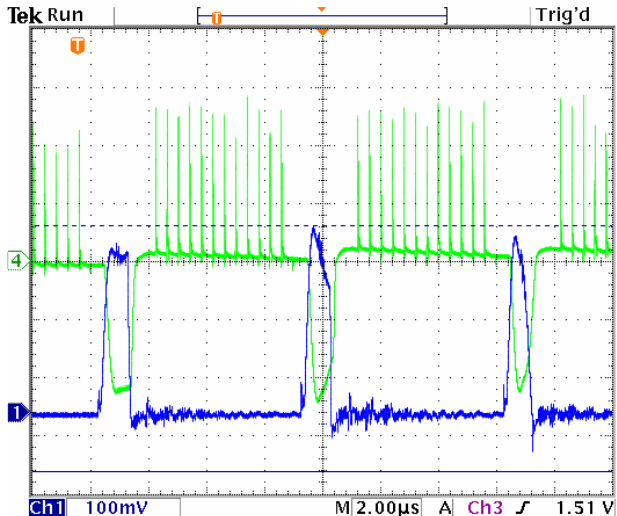
FIG. 13. (Color) Scope traces of the electron beam pulses (blue) and the TEL BPM signal showing electron, proton, and anti- proton bunches. One division of the horizontal axis is 2 micro- seconds. About one Tevatron revolution period is shown here.